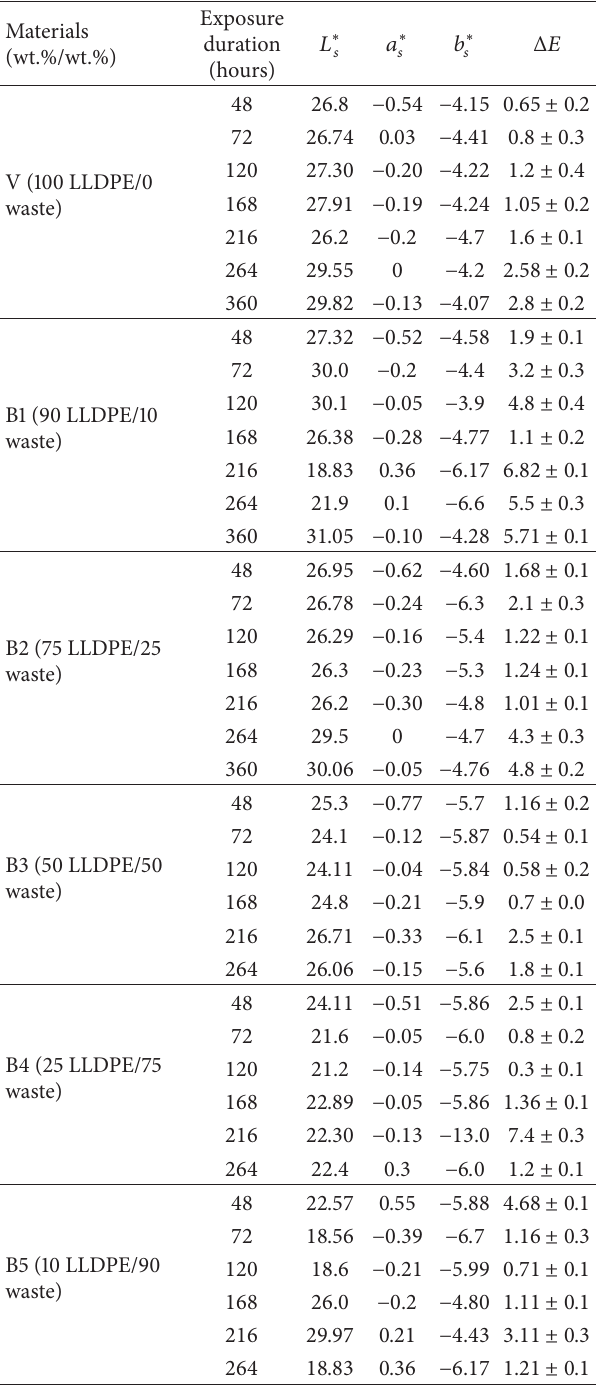
Table 4: Colour parameters and total change in colour ( Δ𝐸 ) for studied formulations at different accelerated weathering exposure (hours) processed at a DHT = 195 ∘